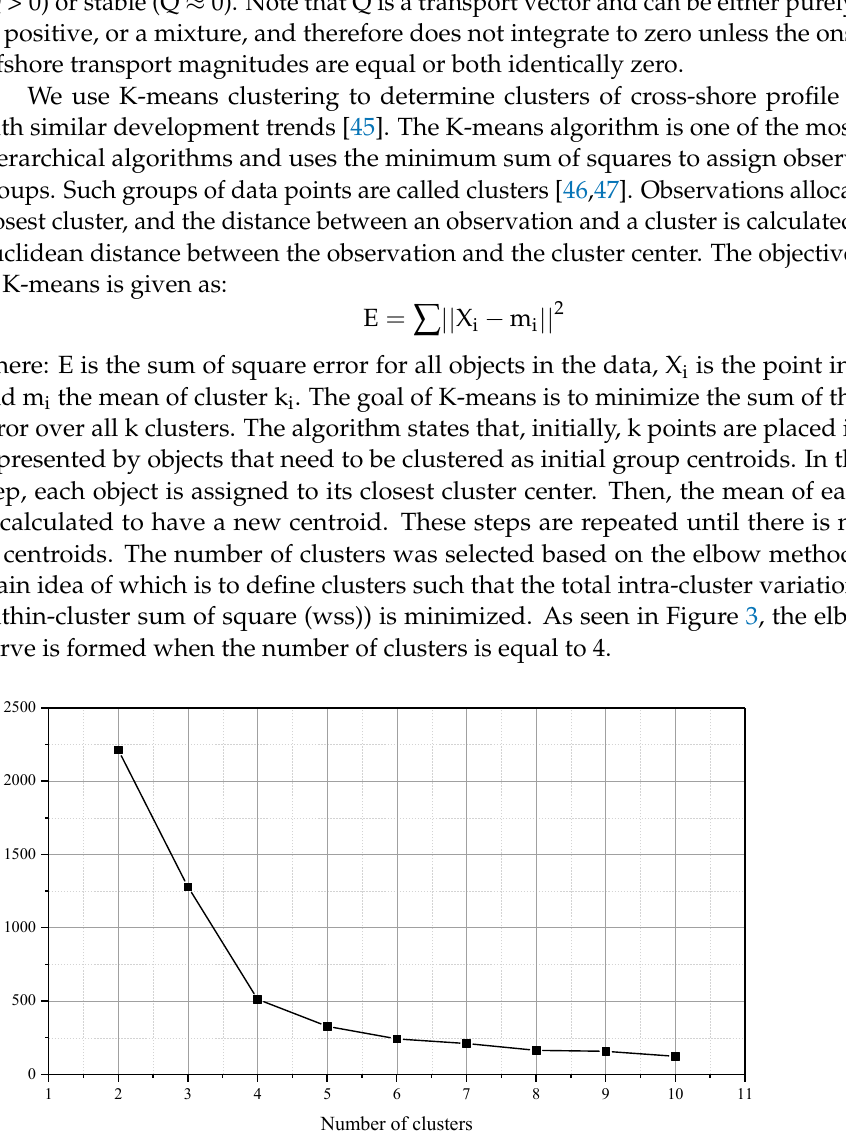
Figure 3. Within cluster sum of square dependence on the number of clusters.